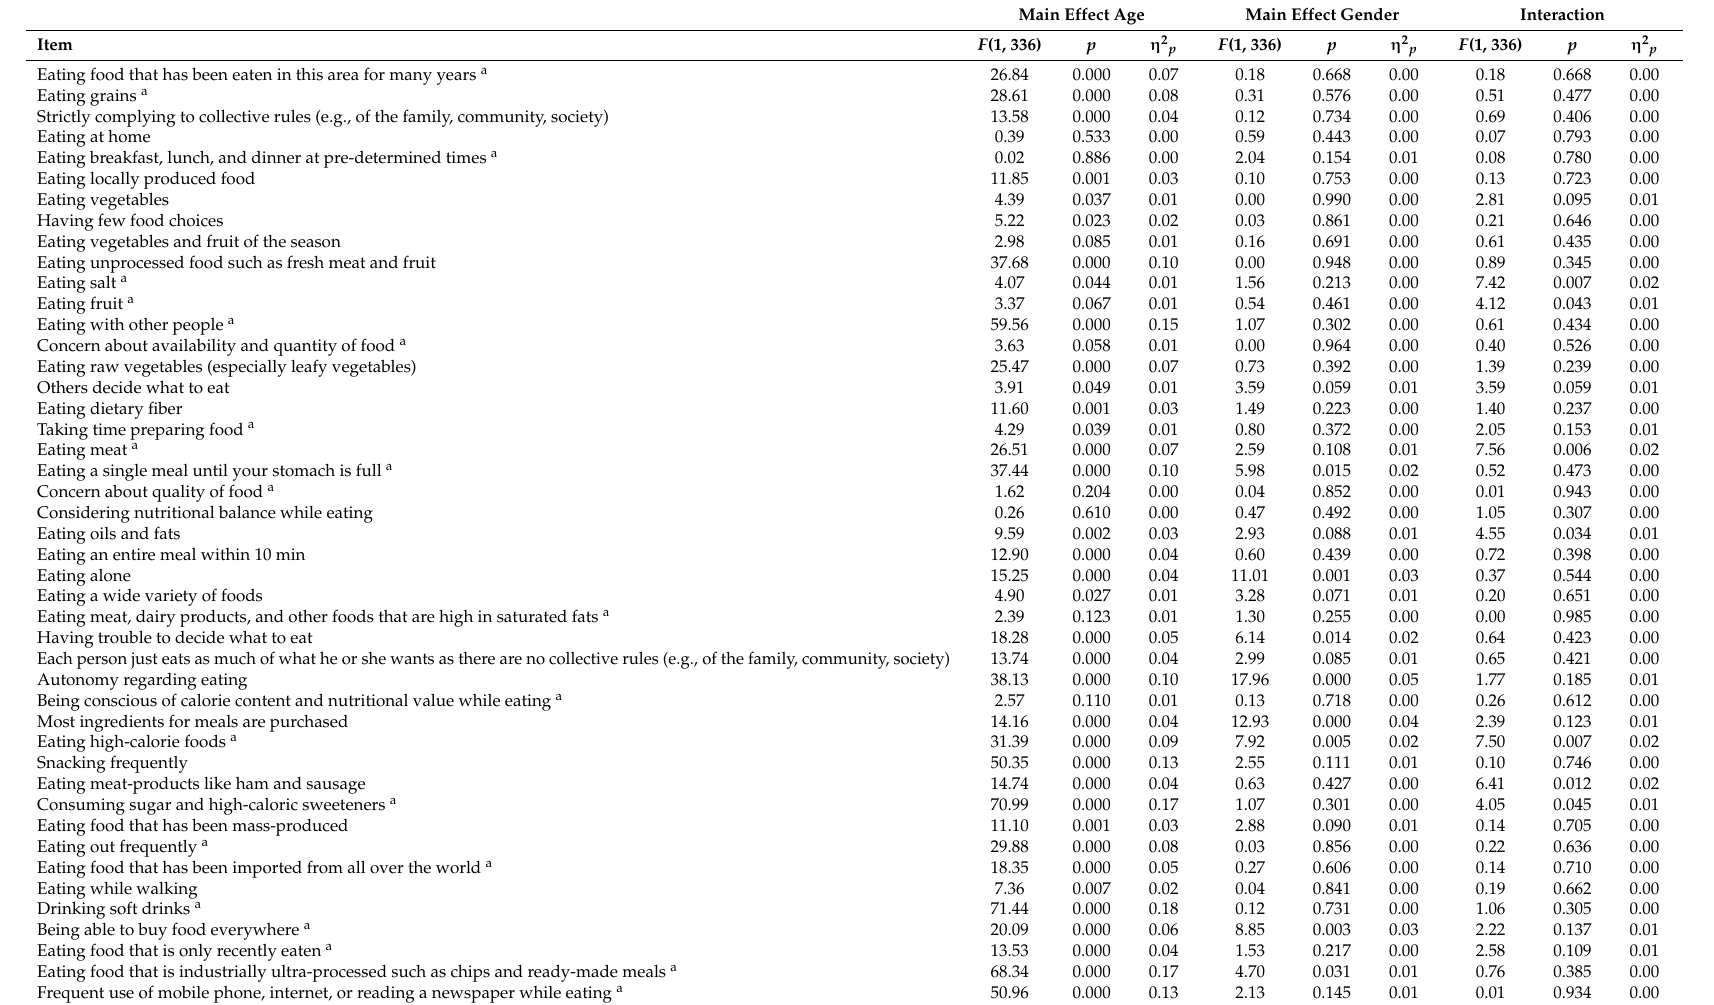
Table A2. Results of a 2 × 2 MANOVA with the factors age (younger vs. older) and gender (men vs.